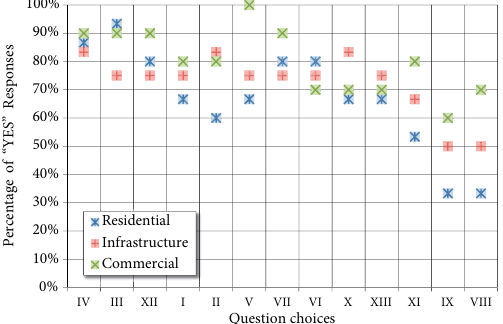
Fig. 11. Marketing activities done in the company according to key interest fields